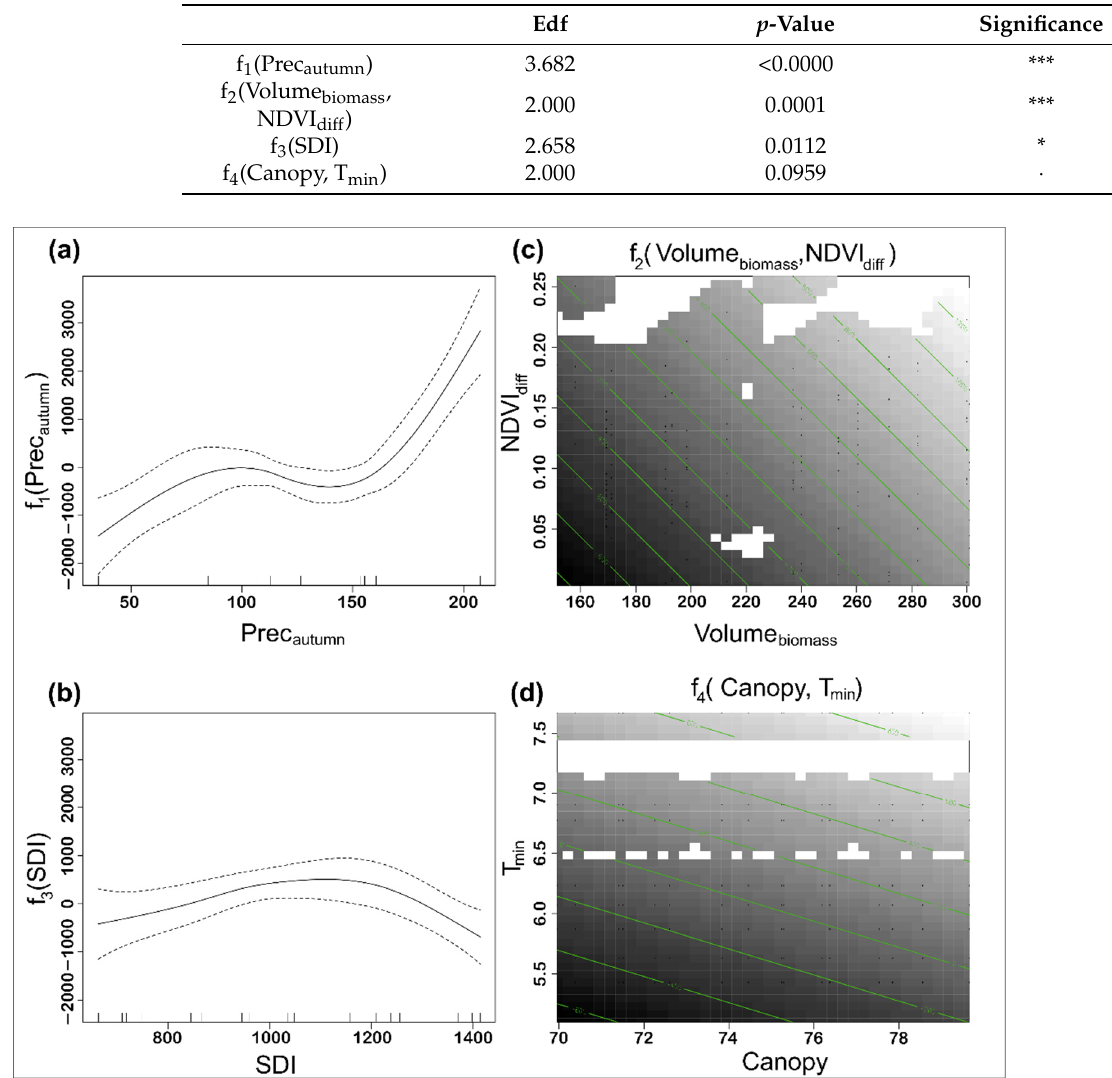
Figure 6. Non-linear effects of the variables for the model developed for all mushroom species together (Equation (2)). ( a ) Prec autumn ; ( b ) SDI; ( c ) interaction between Volume biomass and NDVI diff ; and ( d ) interaction between Canopy and T min . In two-dimensional plots ( c , d ), white shows a positive effect and black a negative effect; green contour lines show where the function has a constant value.